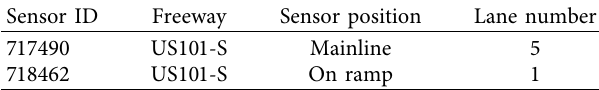
1, 2, 4, 8 and filter size k (cid:31) Table 1: Detailed information on the two